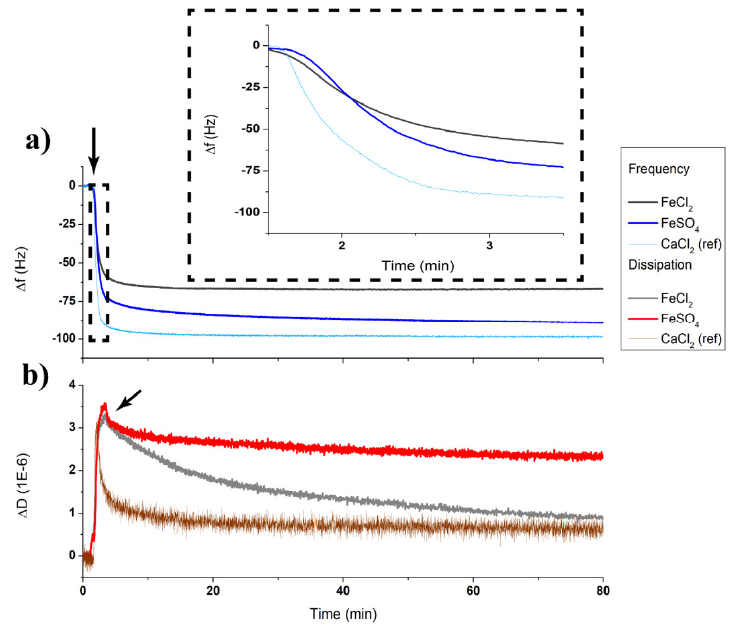
Figure 2. EQCMD measurements showing ∆ f ( a ) and ∆ D ( b ) time evolution for the recrystallization of SbpA protein in the presence of Fe 2+ (chloride and sulphate) and of Ca 2+ divalent ions. Injection was performed on octanethiol-modified gold chips and under controlled bulk potential (–1 V). The black arrow (above) indicates the exact protein injection time. The inset highlights the kinetics of the diffusion/adsorption process. The arrow below points out the appearance of the characteristic structure transition peak observed in ∆